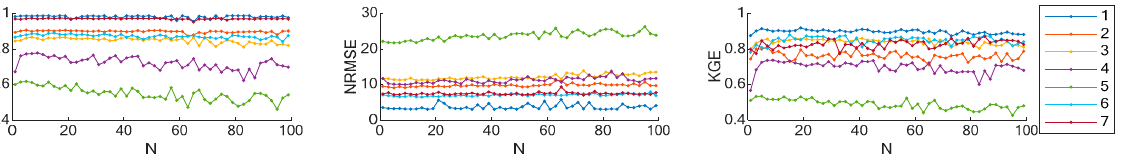
Figure 8. The bilayered neural network (NN) model performance ( CC , NRMSE , and KGE ) depending on the size of hidden layers (N). PCA dataset in the validation phase. 1—air surface pressure (hPa), 2—air temperature (°C), 3—incoming photosynthetically active radiation (µmol/m 2 /s), 4—relative air humidity (%), 5—wind speed (m/s), 6—wind direction (deg), 7—net radiation (W/m 2 ), 8—soil temperature at 5 cm (°C).